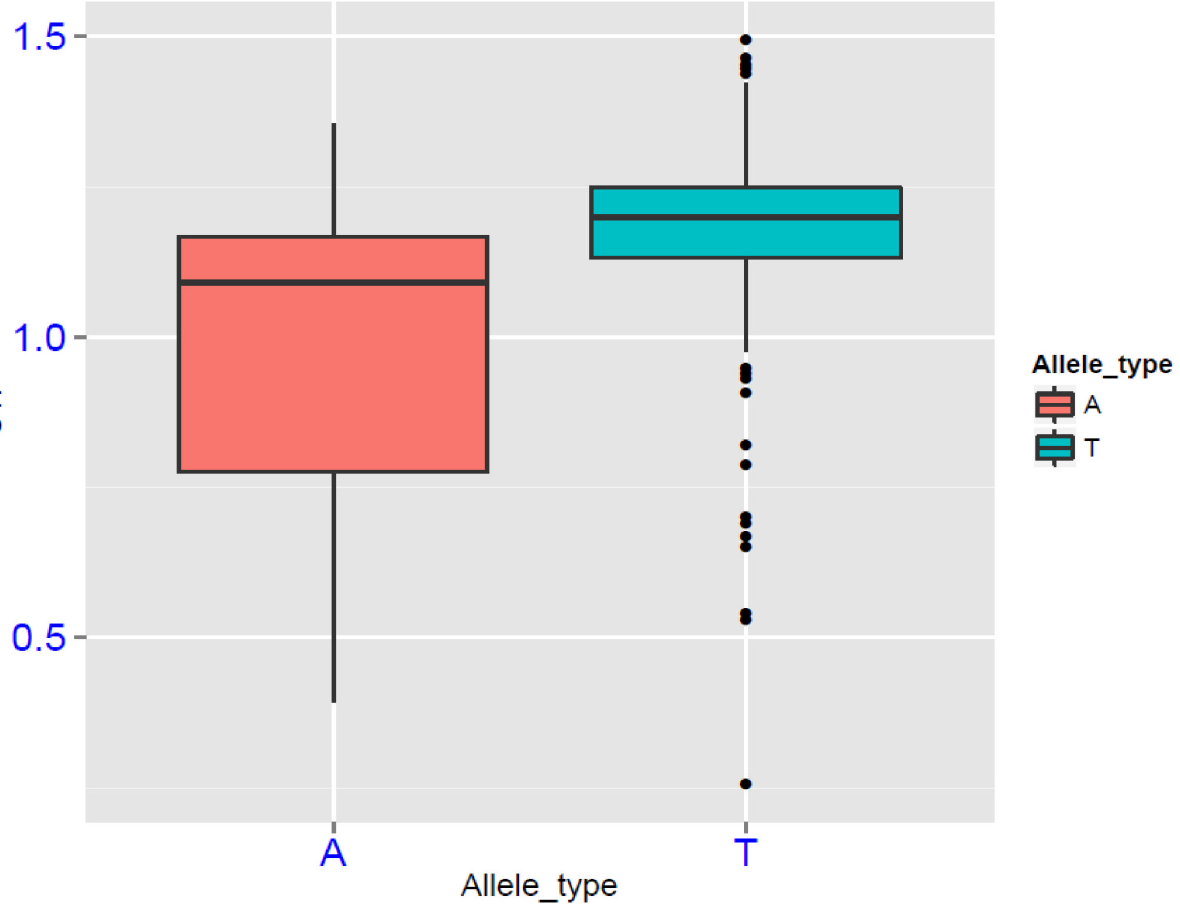
Fig 2. EHH plot across the BADH1 and BADH2 genomic region. (a) EHH of BADH1 genomic region. Wild type (T) and P11483 (A) did not show large LD block. (b) EHH of BADH2 genomic region. The fragrant accessions carrying the P2 3036 ( badh2 . 1 which has 8 bp deletion in exon 7) allele exhibited a large block of extended LD around the FNP, while wild type allele declined rapidly.